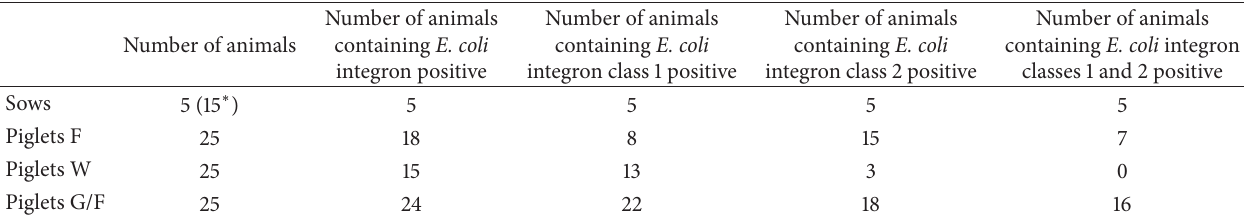
Table 1: Details of the total number of animals tested and samples obtained.